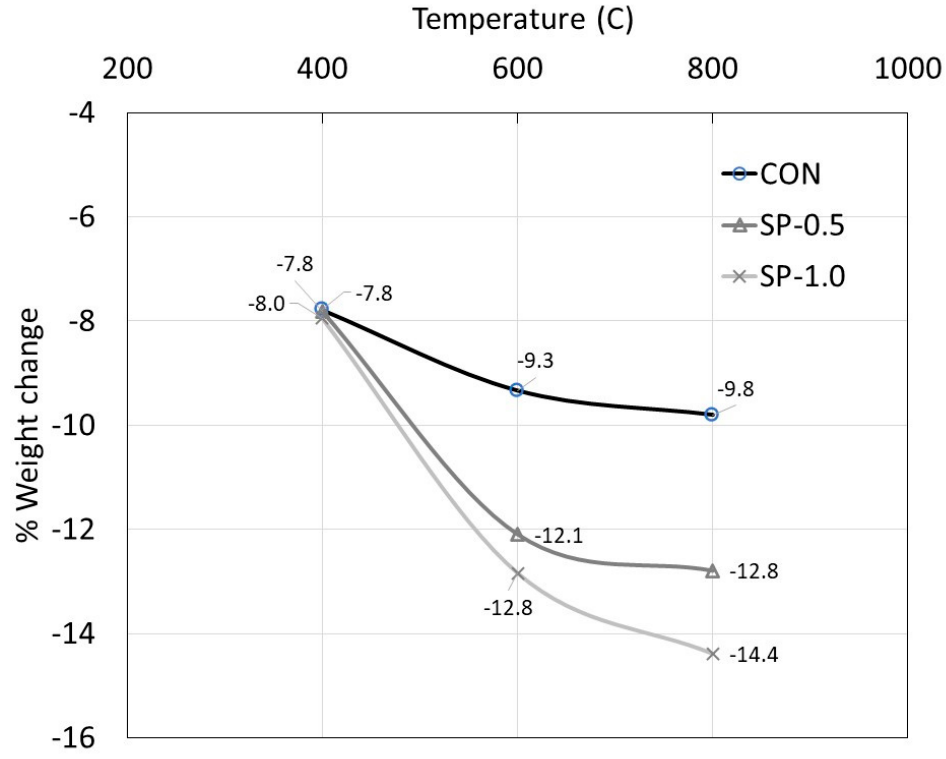
Figure 6. Weight change percentage after being heated.